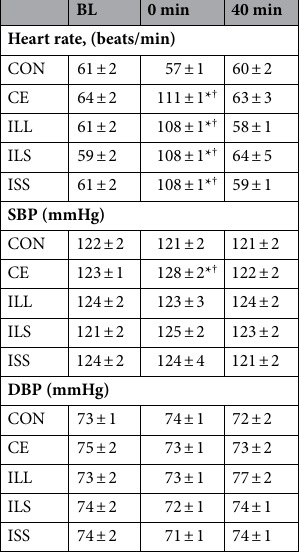
Table 2 indicated that heart rate was significantly elevated at 0 min in CE, ILL, ILS and ISS trials ( P < 0.01) compared to their baseline. Systolic blood pressure increased significantly at 0 min compared to its baseline in CE ( P < 0.01). The mean (± SD) changes of ⊿ CAVI in the five trials were presented in Figs. 2 and 3. ⊿ CAVI remained